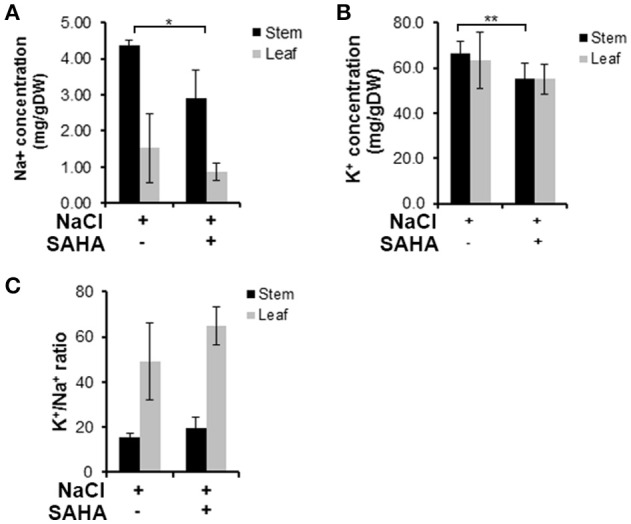
Na+ and K+ content in stems and leaves under high salinity stress. (A,B) Na+ and K+ concentrations in the stems and leaves of plants exposed to 100 μM SAHA then subjected to 200 mM NaCl for 2 h. (C) the K+/Na+ ratio of stems and leaves of cassava plants. Asterisks indicate significantly different means (*p < 0.02, **p < 0.05) as determined with a t-test. Error bars represent the mean ± SD. Three independent biological replicates were performed for each condition.